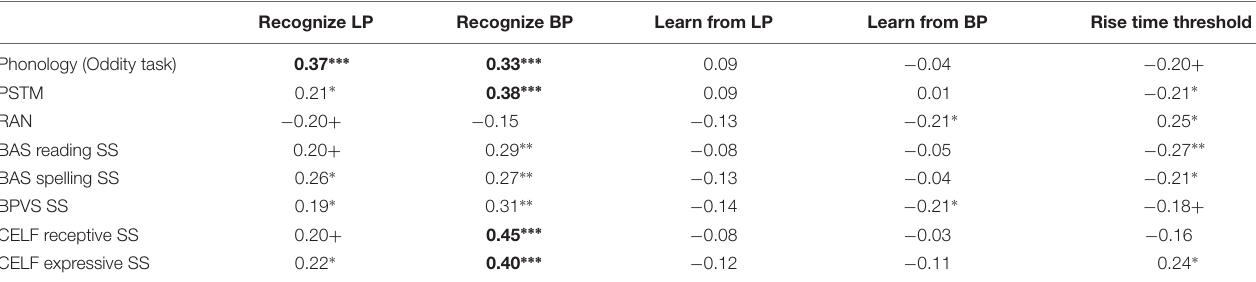
TABLE 8 | Partial correlations between SLI children’s performance in the phonology, vocabulary and reading/spelling outcome measures and their filtered speech performance and rise time discrimination thresholds, controlling for age and IQ. Recognize LP Recognize BP Learn from LP Learn from BP Rise time